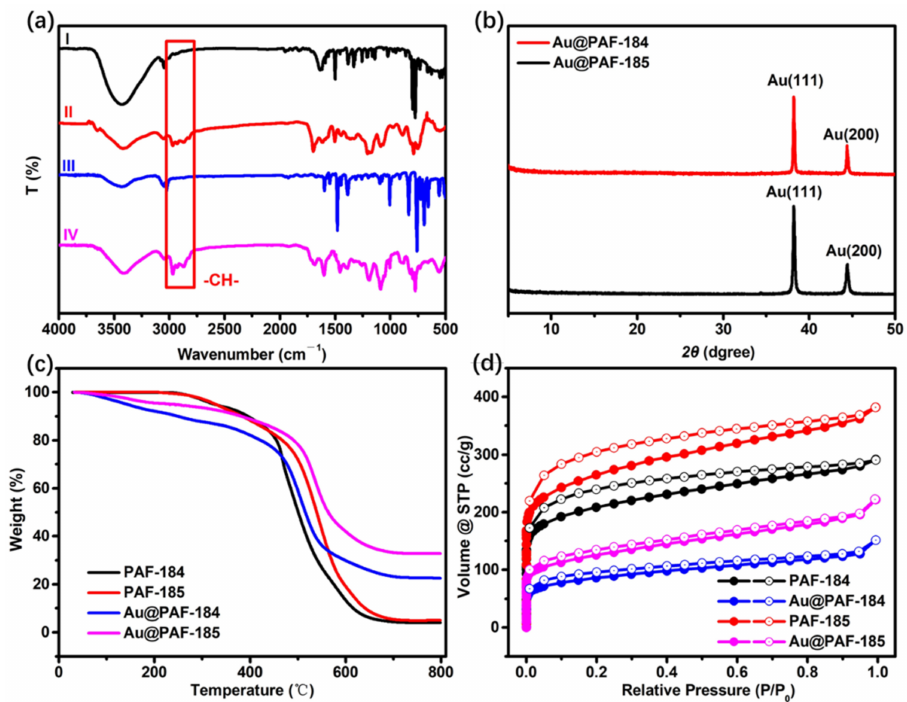
Figure 1. Some characterizations of PAFs and Au@PAFs: ( a ) FT-IR spectra of tris(1-naphthyl)phosphine (I, black), PAF-184 (II, red), tris(4-biphenyl)phosphine (III, blue) and PAF-185 (IV, magenta); ( b ) PXRD patterns of Au@PAF-184 and Au@PAF-185; ( c ) TGA plots of PAFs and Au@PAFs; ( d ) N 2 adsorption– desorption isotherms of PAFs and